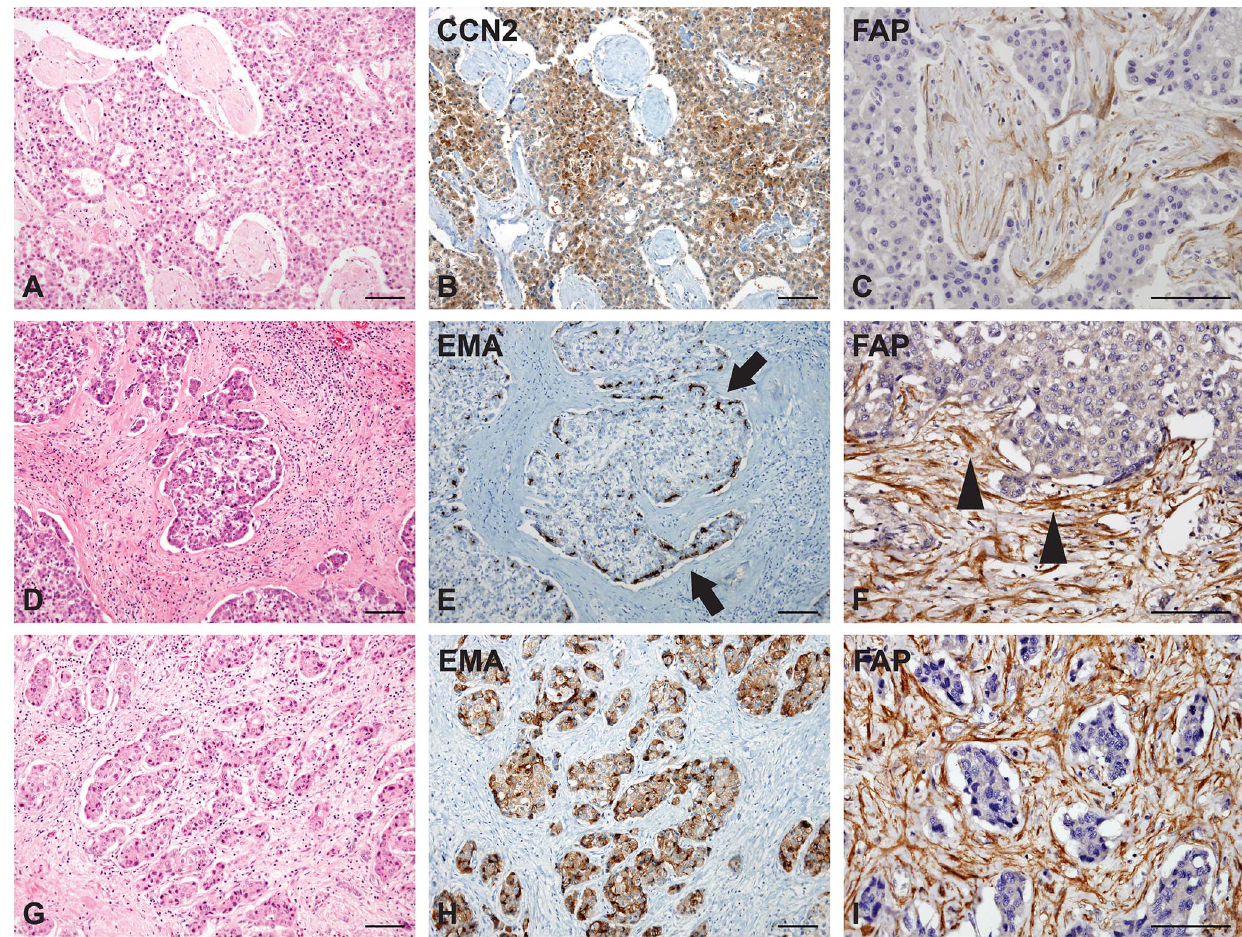
Figure 3. Connective tissue growth factor (CCN2), epithelial membrane antigen (EMA), and fibroblast activation protein (FAP) expression in scirrhous hepatocellular carcinomas (HCCs with abundant fibrous stroma) of cohort 2. A–C) CCN2 (B) is diffusely expressed in the nests of tumor epithelial cells, and the tumor stromal cells between the nests of tumor epithelial cells exhibit strong FAP expression (C). D–F) EMA is mainly expressed in the periphery (E, arrows) of large tumor nests in contact with FAP-expressing cancer-associated fibroblasts (CAFs) of tumor fibrous stroma (F, arrowheads). G–I) HCCs with small nests or a trabecular pattern show diffuse expression for EMA in the tumor epithelial cells (H), which are closely admixed with FAP-expressing CAFs of tumor stroma. (Scale bars represent 100 m